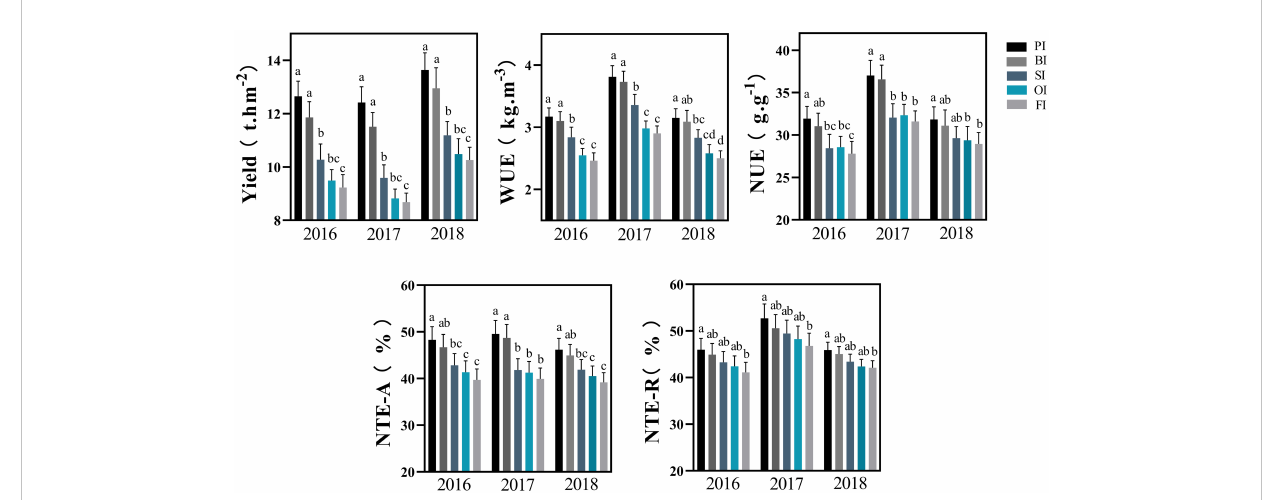
FIGURE 1 Yield, water, and N use ef fi ciency with the different irrigation treatments. PI and BI represent drip irrigation under plastic fi lm mulch and biodegradable fi lm mulch, respectively; SI, drip irrigation incorporating straw returning; OI, drip irrigation with the tape buried at a shallow soil depth; FI, furrow irrigation. WUE, soil water use ef fi ciency; NTE-A, N translocation ef fi ciency for above ground parts; NTE-R, N translocation ef fi ciency for roots; NUE, N use ef fi ciency. The error bars represent standard deviations. Different lowercase letters indicate signi fi cant differences at P < 0.05. The data in this fi gure are presented in Table S2 for further